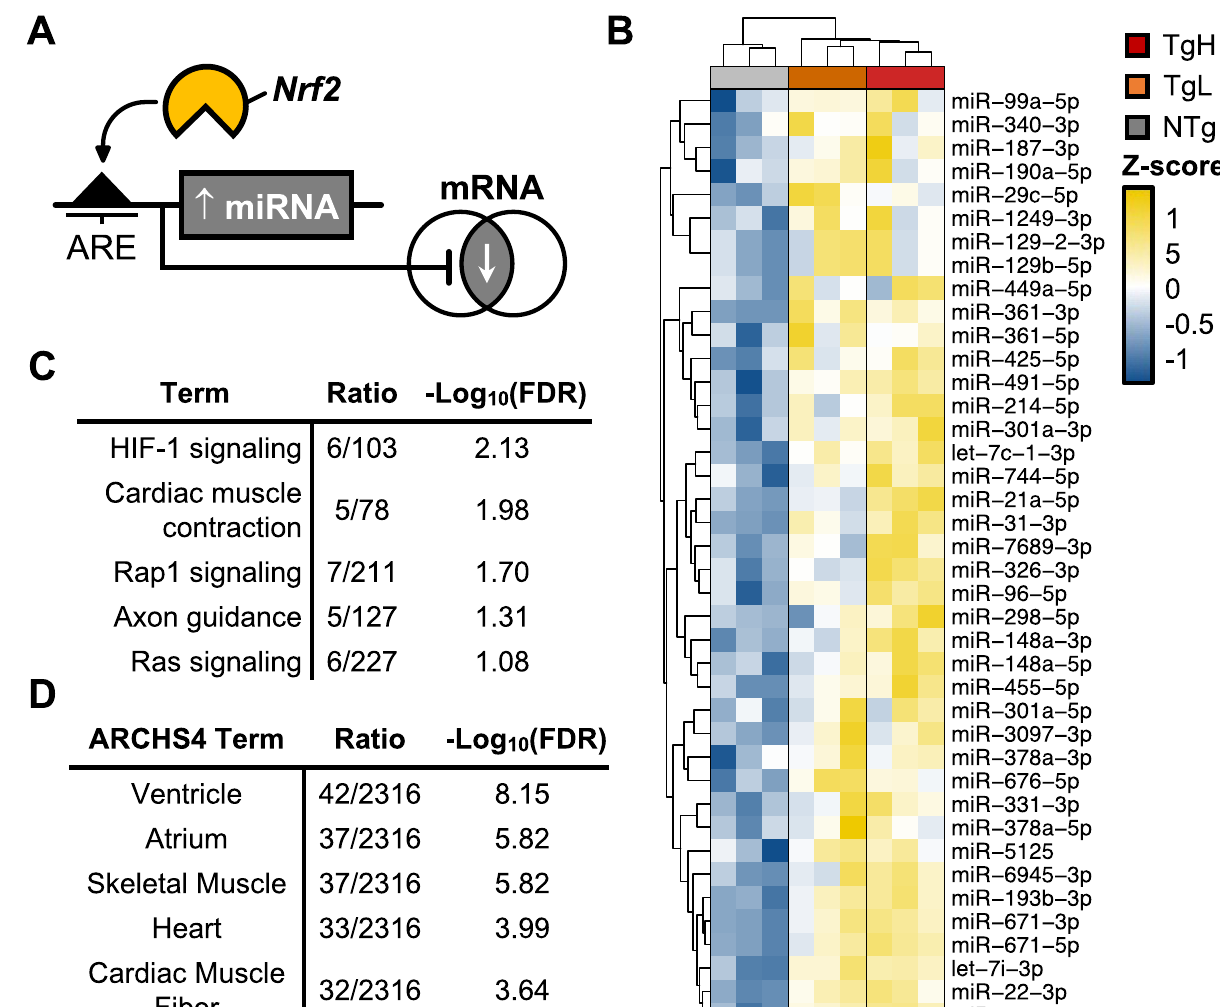
Figure 4. Elucidation of Antioxidant Response Element (ARE)-containing DEmiRs and their Putative mRNA Targets. ( A ) Graphical model representing Nrf2 -dependent regulation of miRNA and downstream mRNA. ( B ) The 40 induced DEmiRs* (Tg Vs. NTg) containing at least one proximal (+ 5kB) upstream ARE. ( C ) Gene set enrichment (GSEA) of KEGG pathways and ( D ) ARCHS4 gene atlas-based enrichment using DEGs identified as putative targets of ARE-containing DEmiRs. *P <